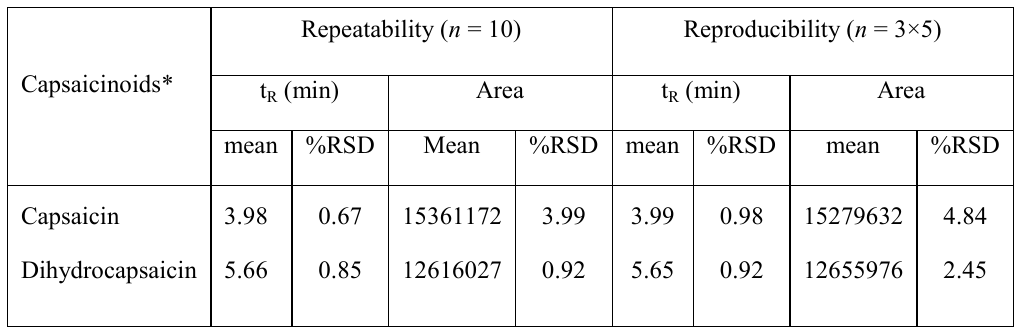
Table 1. Repeatability ( n = 10) and reproducibility ( n = 3×5) of capsaicinoids analysis by RP-HPLC-fluorescence